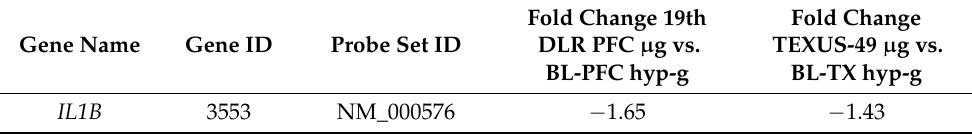
Figure 13. Time course of differential expression of 375 probe sets in human U937 cells after microgravity exposure (list of probe sets in Supplementary Table S1). Human U937 cells were exposed to 20 s and 300 s of microgravity. The probe sets are grouped according to their regulation after the two exposure times. Continuous response means that probe sets are either up-regulated or down-regulated at both time points. Adaption is either the disappearance of the microgravity-induced effect or regulation in the opposite direction after 300 s. A late response is a regulation that only appears after 300 s. Most of the probe sets did not respond to microgravity at either time point. For the abbreviations of the experiment group names see Table 1. Table 12. Differentially regulated probe set in a continuous manner in 20 s and 300 s of microgravity identified in human U937 cells in the 19th DLR parabolic flight and TEXUS-49 suborbital ballistic rocket campaigns. One probe set, belonging to one gene was differentially regulated with respect to both altered gravity platforms. Minus: significantly down-regulated probe set ( p -value < 0.05). FCs are ratios between the averages of linear expression values. If the ratio is <1, FC is calculated as the negative reciprocal of the ratio. For the abbreviations of the group names see Table 1.